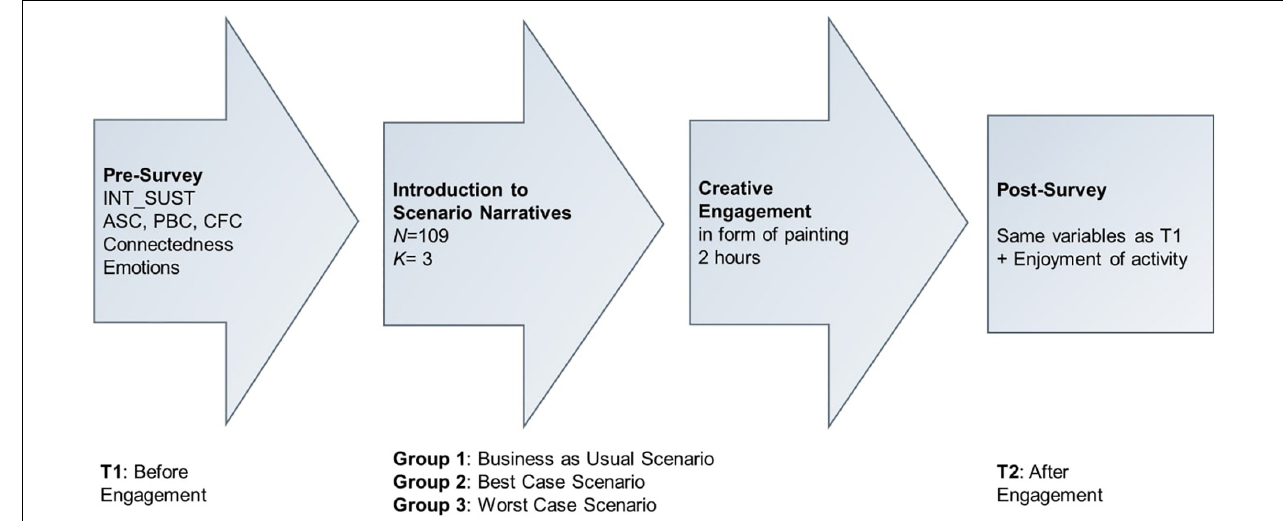
FIGURE 1 | Illustration of steps, sample size, and group structure of the study’s quasi-experimental design.